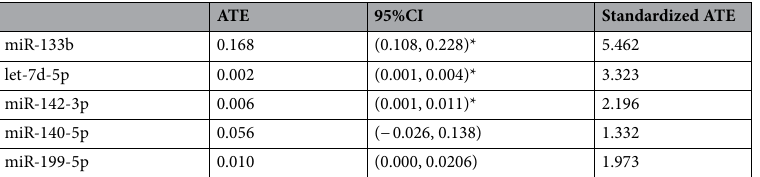
Table 3. Validation analysis of target miRs differentiating IS + and SS + groups. ATE, average treatment effect: weighted mean difference of miR levels between SS + and IS + ; Standardized ATE, ATE divided by bootstrapped SD of ATE. *Statistically significant, zero not included in 95% CI.